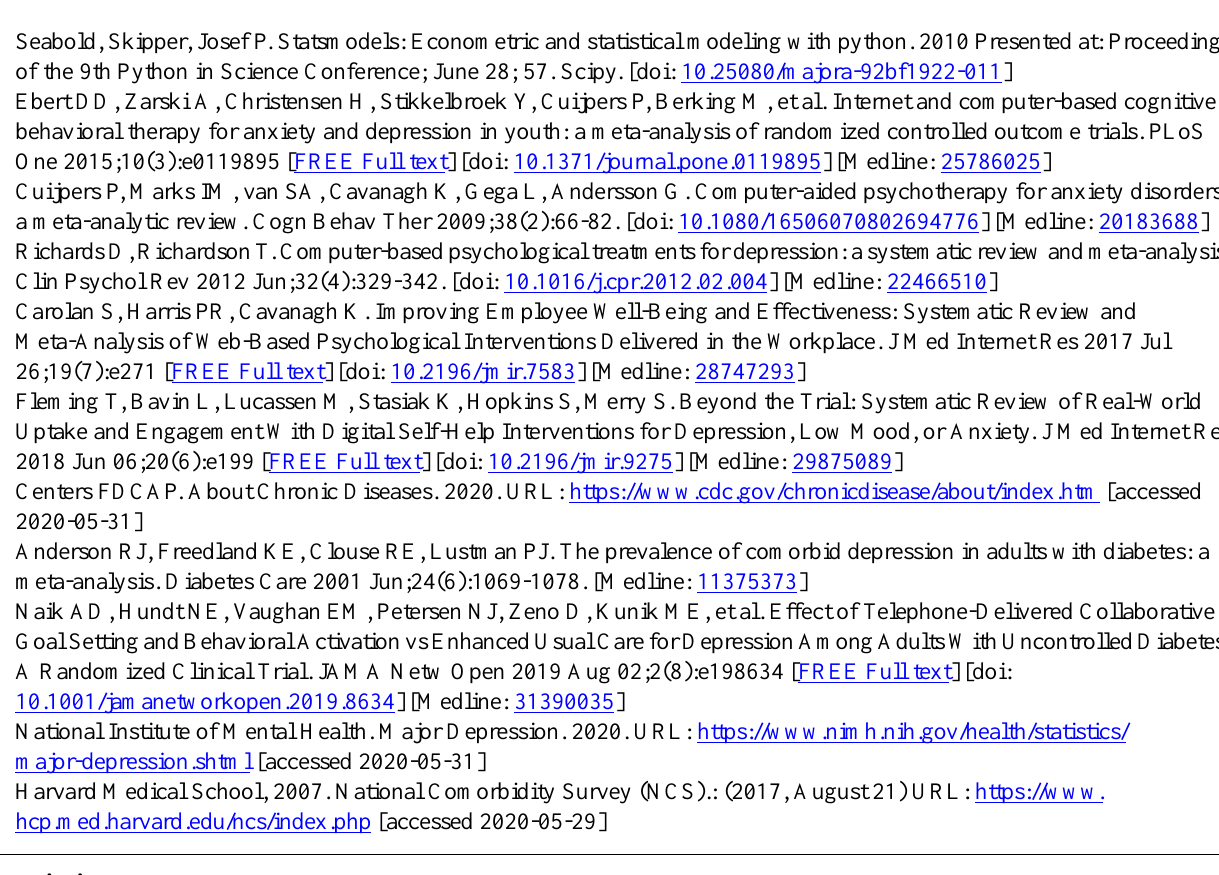
GAD-7: Generalized Anxiety Disorder,